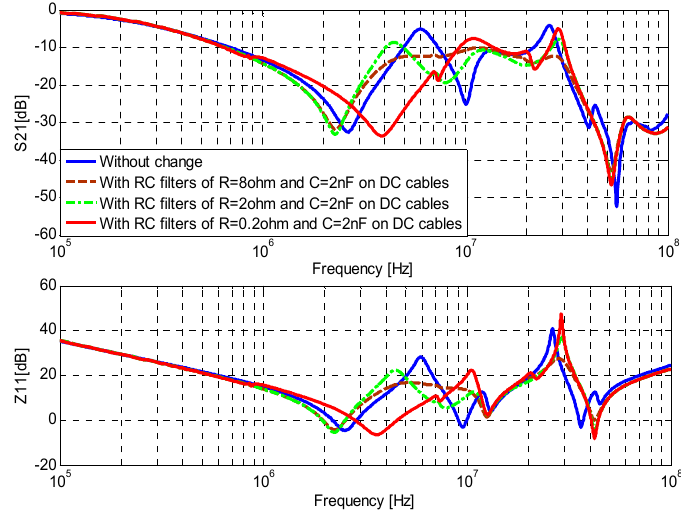
Figure 14. Current ‐ following path at 6 MHz after adding an RC filter in front of the DC cables.